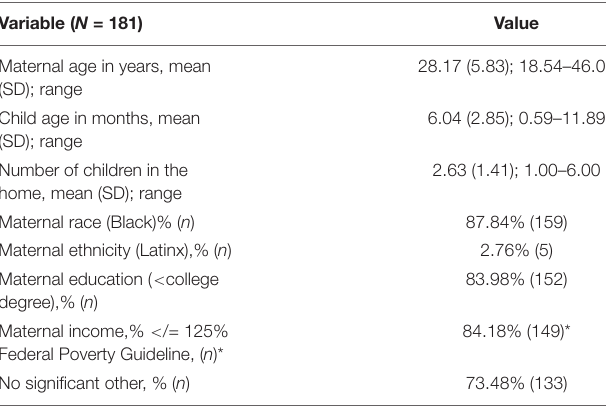
TABLE 1 | Demographic characteristics of the pre-intervention